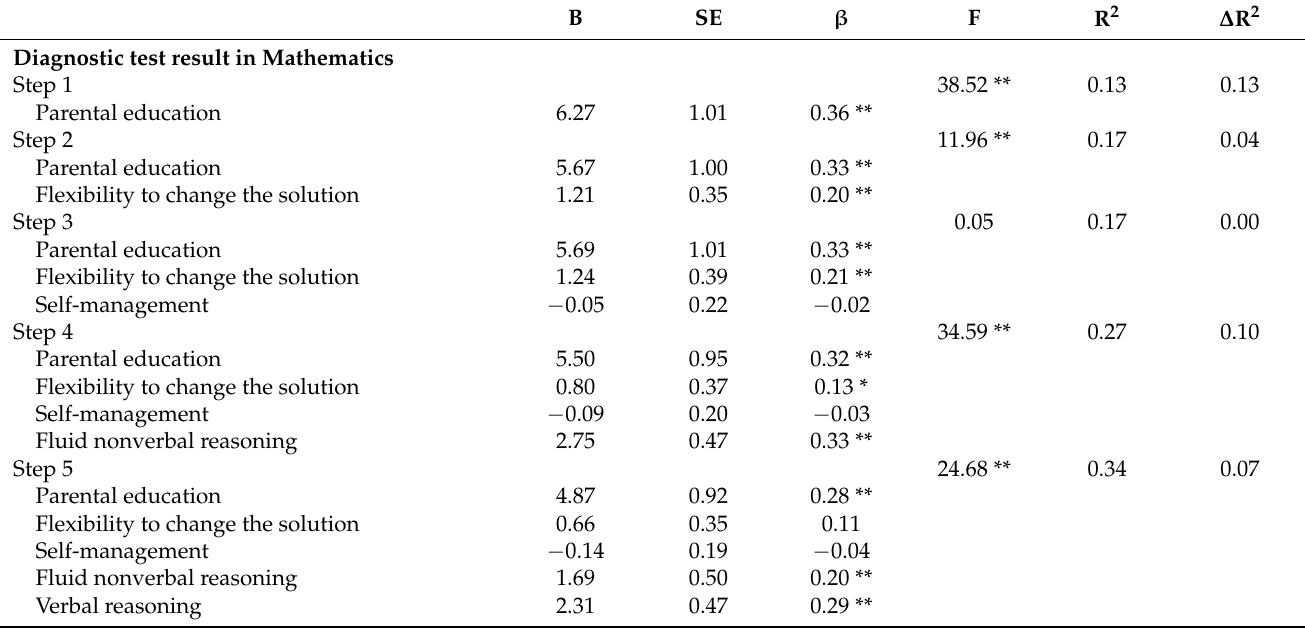
Table 3. Regression analysis of the result of the diagnostic test in Mathematics ( n = 256) with independent variables: Parental education level, one scale of Problem-solving: Flexibility to change the solution, Self-management, Fluid nonverbal reasoning and Verbal